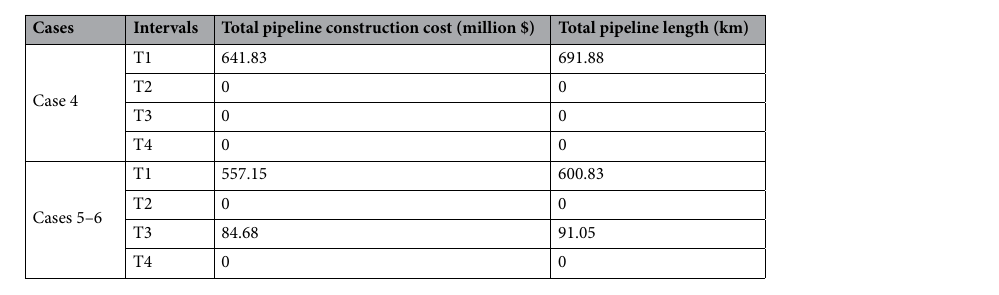
Figure 5. Final optimized CO 2 pipeline network for Case 4. Blue dots represent sinks, red dots represent CO 2 point sources, and green curves indicate the optimized pipeline routes (the number and thickness denote the pipeline diameter).